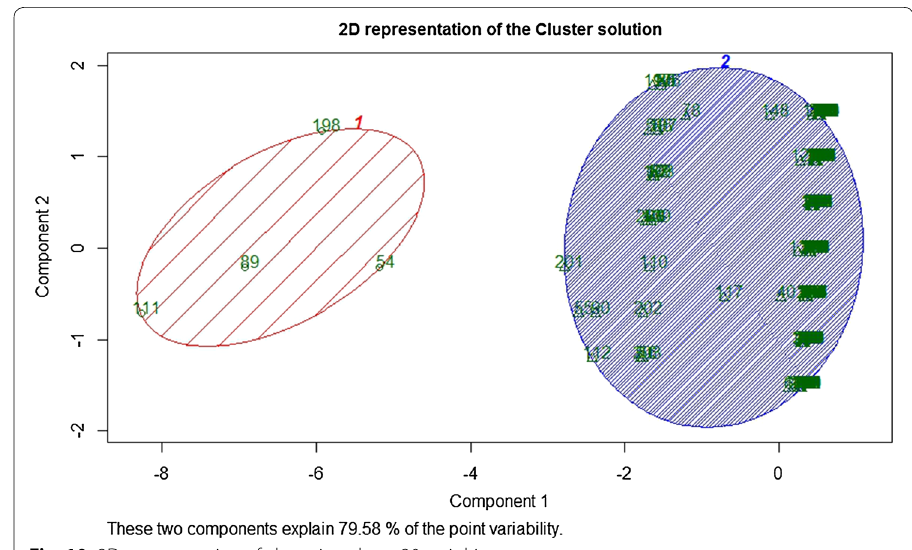
Fig. 10 2D representation of clustering about 30 taxi